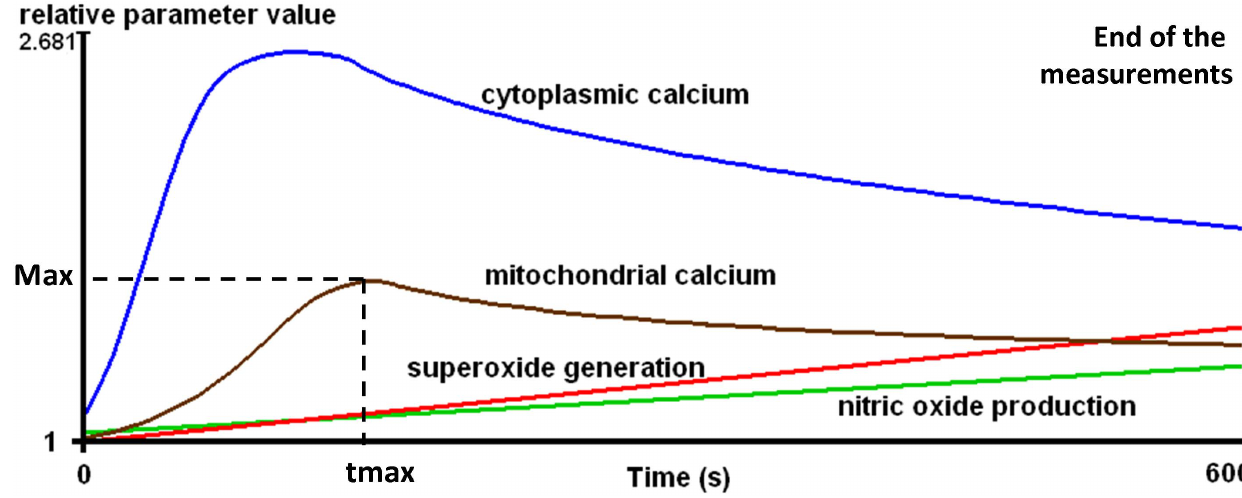
Figure 1. Schematic demonstration of kinetic parameters of the investigated intracellular processes during the activation of T- lymphocytes. Max=Maximum value, tmax=Time to reach maximum.